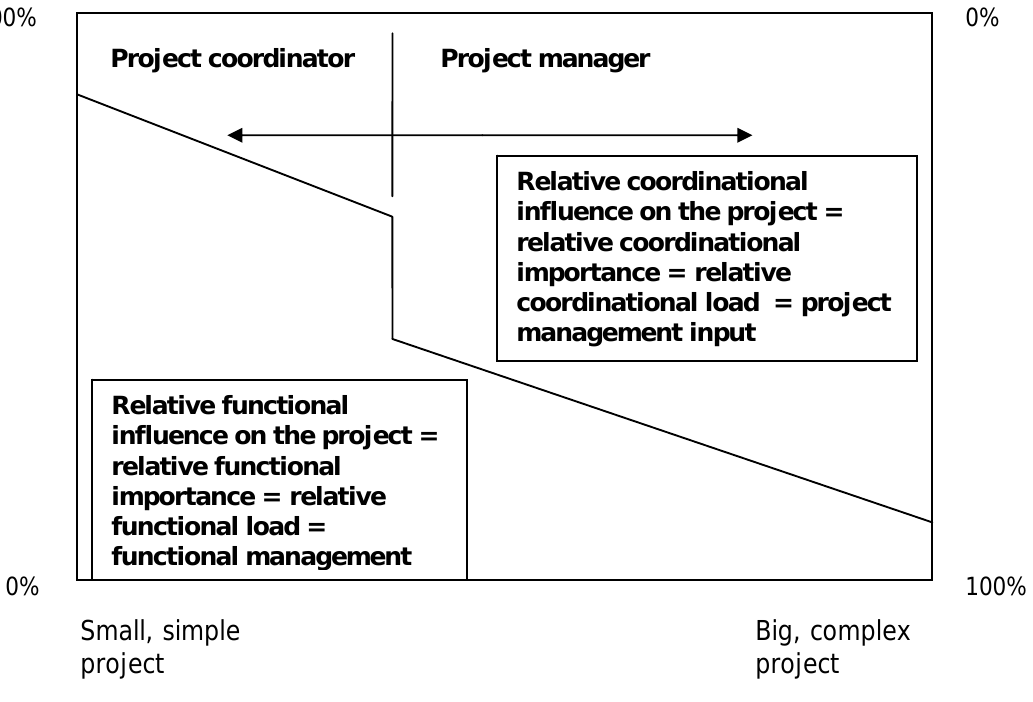
Figure 1: The changing relationship of the functional load to the project management load along the continuum of project complexity (size).